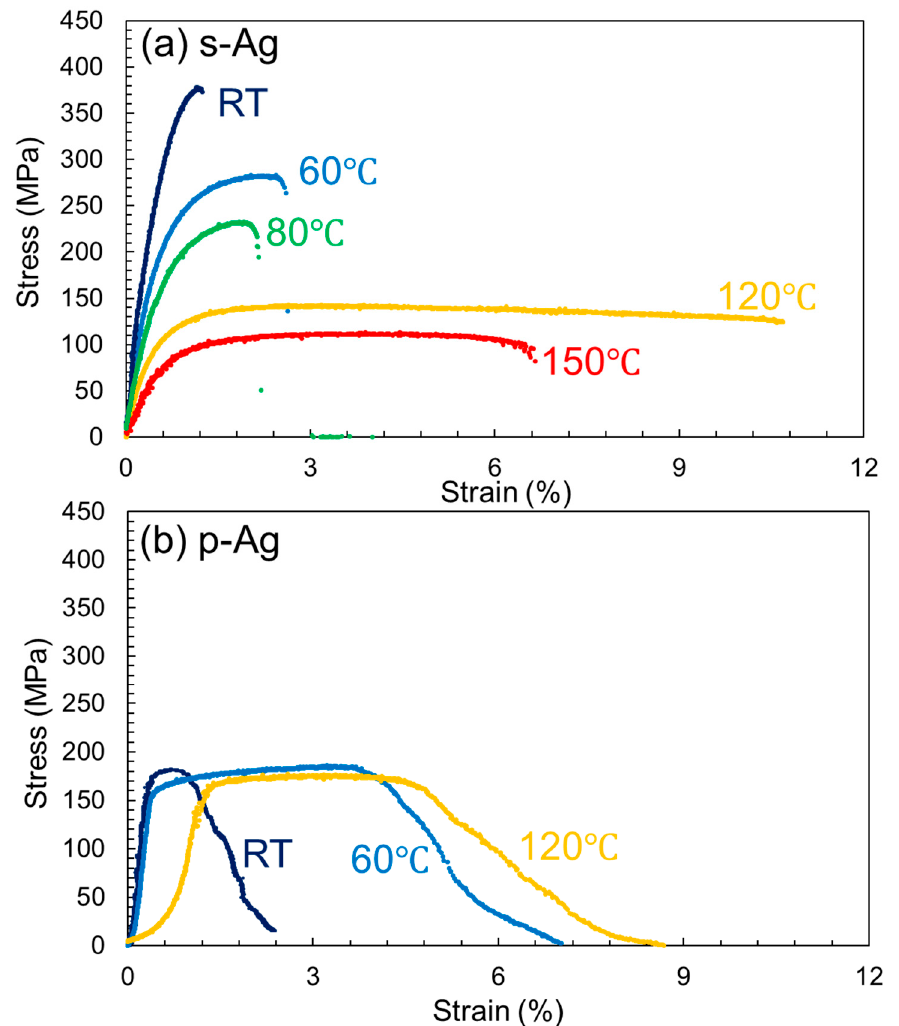
Figure 4. Stress–strain ( S-S ) curves for each temperature ( a ) s-Ag ( b ) p-Ag.